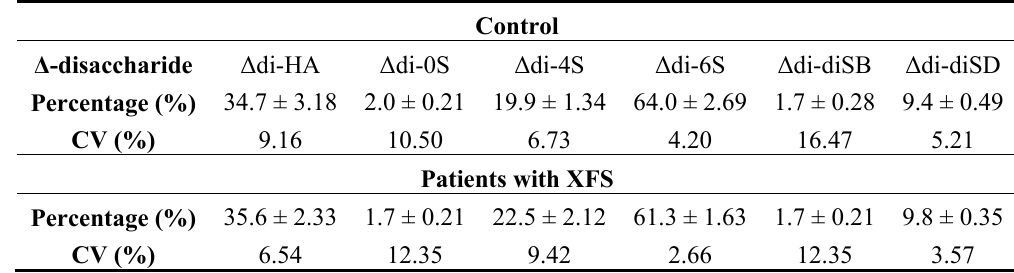
Table 2. CS sulfation pattern, hyaluronan composition and average composition of lens capsules from individuals without (control) and with XFS. The percentage of CS disaccharides refers to the total amount of CS disaccharides, whereas the percentage of hyaluronan refers to the amount of both CS and hyaluronan